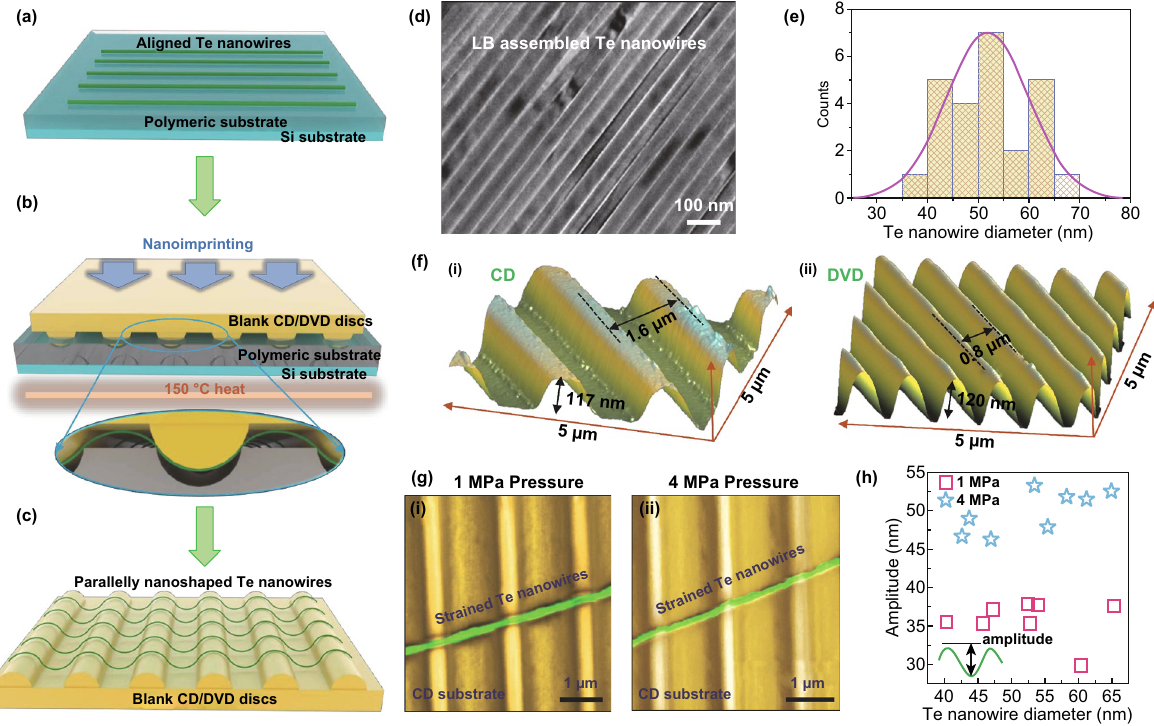
Fig. 2 Fabrication and topography characterization of the parallelly deformed 1D Te. a – c Schematic procedure of fabricating the wavy geom- etry of 1D Te nanowire on optical disks. d Transmission electron microscope image of the assembled 1D Te nanowire on the copper grid. e The thickness distribution of the as-synthesized 1D Te nanowire. f Atomic force microscopes (AFM) image of the optical disks. g Scanning electron microscope images of the deformed 1D Te nanowire by 1 and 4 MPa nanoimprinting pressure. h The relationship between the deformed ampli- tude and Te nanowire